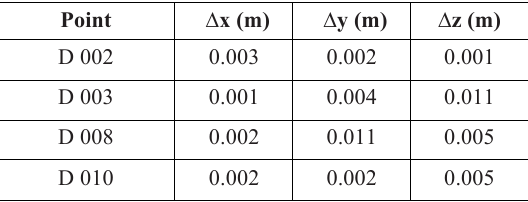
Table 11: Precisions on the check points.